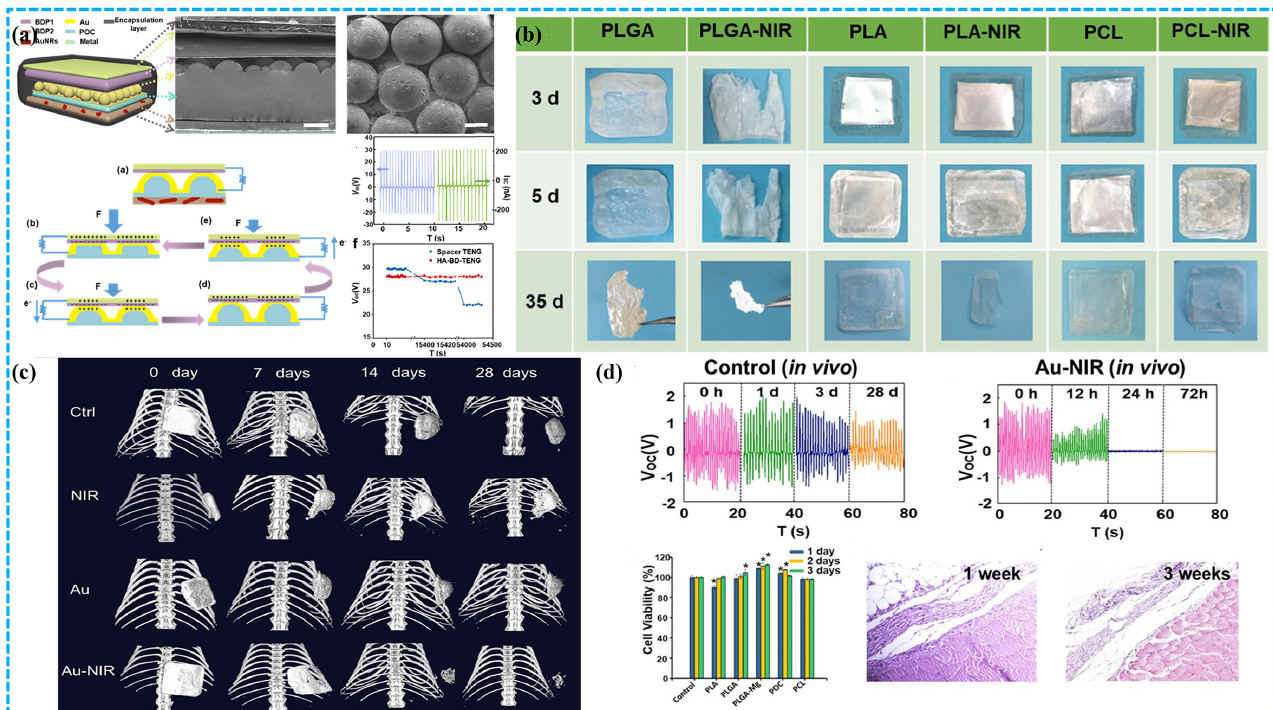
Figure 15. A solar-triggered transient energy harvester and sensor based on TENG using acid-sensitive polyphenylene glycol: ( a ) structure design of the photothermal-controlled BD-iTENG; working principle of the BD-iTENG. V oc and I sc of BD-iTENG; stability of spacer-based iTENG and as fabricated HA-iTENG; ( b ) biodegradation of the BD-iTENG made from PLGA, PLA and PCL in PBS at 37 °C with or without NIR laser; ( c ) micro-CT image of the implanted PLGA-iTENGs at various time points; ( d ) the electrical output of the PLGA-iTENG without AuNRs or NIR; ( c ) the electrical output of the PLGA-iTENG with AuNRs and NIR. Reproduced with permission [130], Copyright 2019, WILEY-VCH.